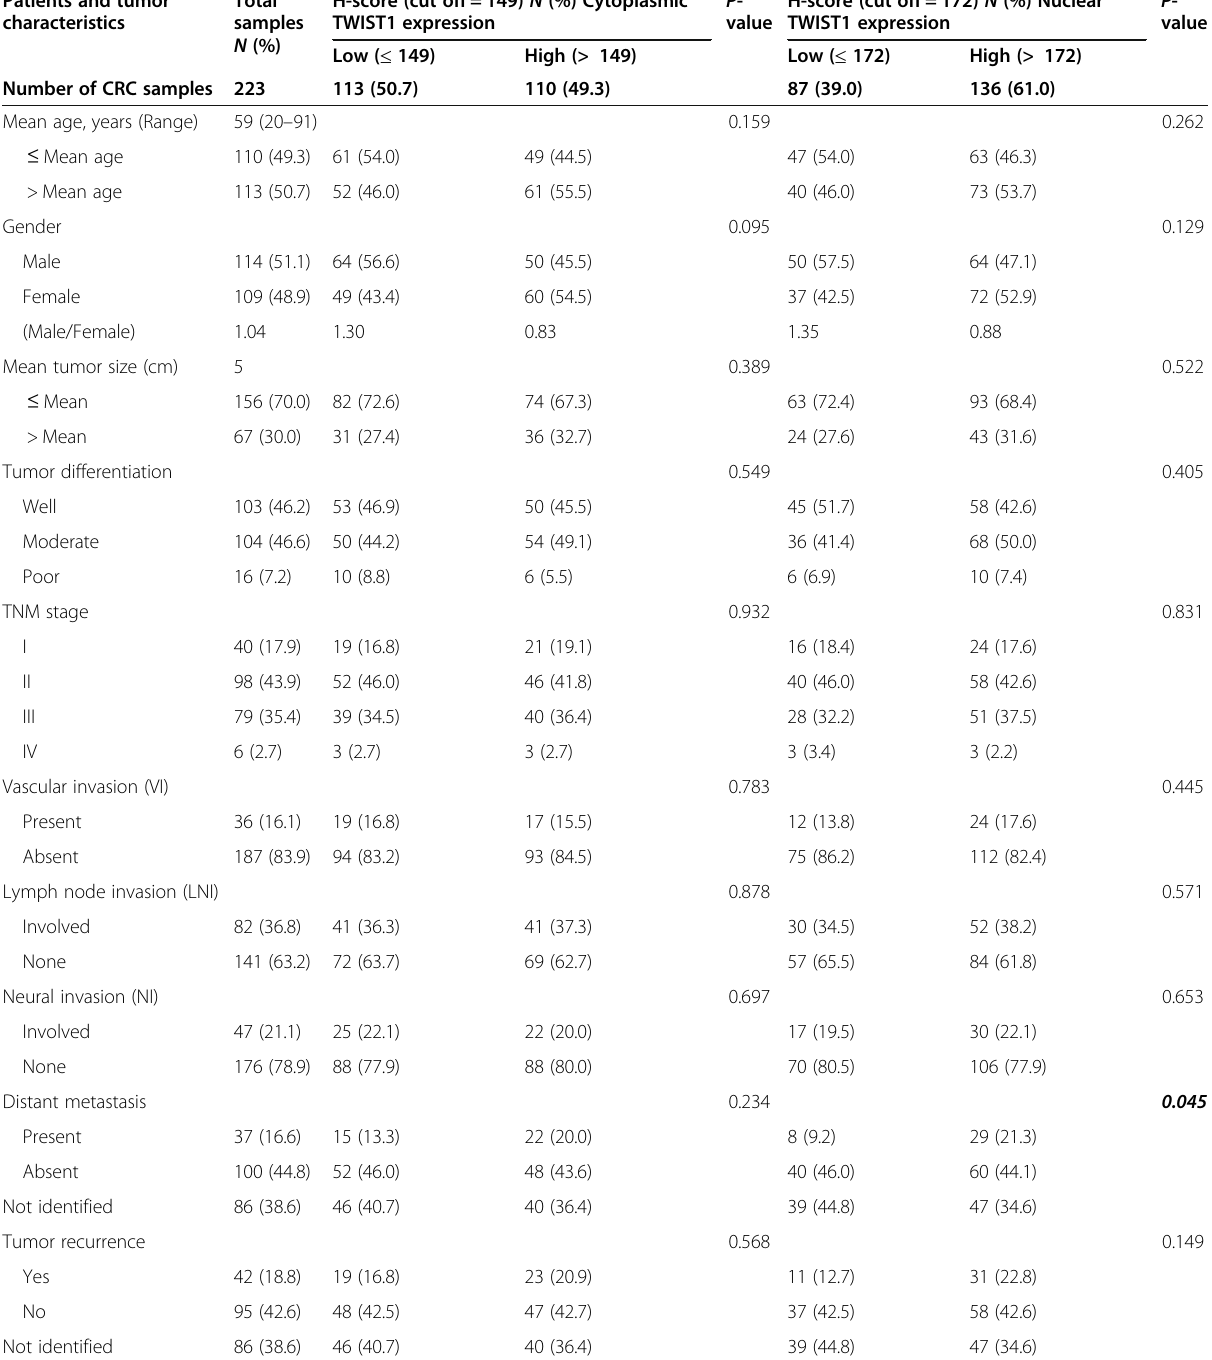
H-score indicates histological score Values in bold are statistically